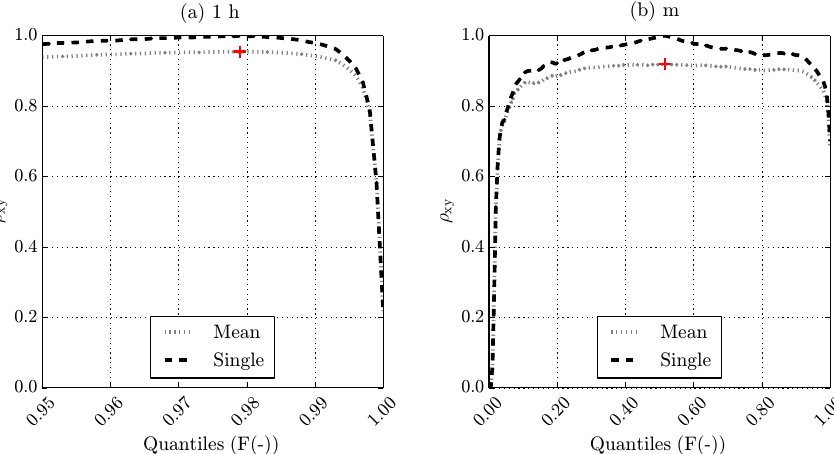
Figure 5. The mean rank correlations ρ xy of the (a) hourly (1h) and (b) monthly (m) quantile values for all gauge pairs of discrete quantiles in 0.001 (1h) and 0.005 steps (m) ranging from Q th to 1 (the gray dotted line). They are calculated to define the control quantile ( Q c ), which exhibits the highest mean rank correlation ρ xy (the red cross). The black dashed line shows the (single) rank correlations ρ xy of the quantile values at Q c (the red cross) with the quantile values of the remaining